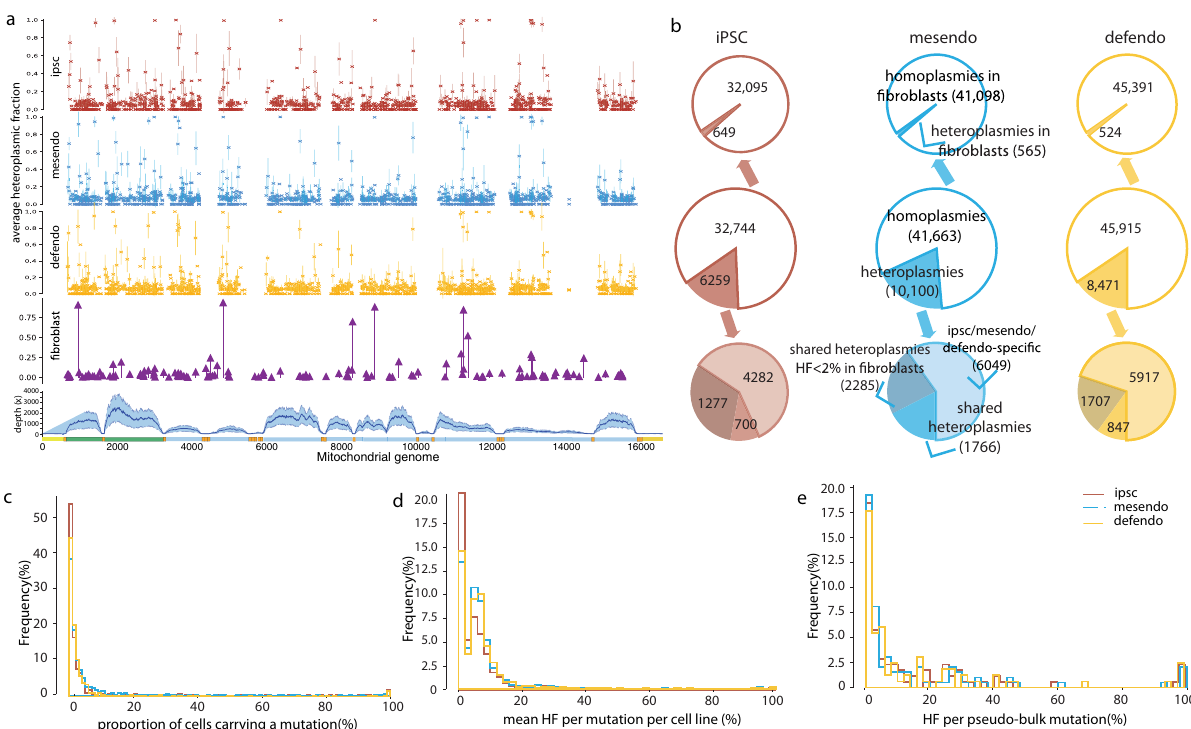
Fig. 4 Overview of mtDNA variants detected by single-cell RNA sequencing. a From top to bottom, mtDNA variants detected from single-cell RNA sequencing, cells de fi ned as iPSC, mesendo and defendo stages are shown separately. Each dot represents the mean HF of each variant per cell line, and the error bar was 95% con fi dence interval; mtDNA variants observed in their fi broblast cells from bulk whole-genome sequencing (purple plot); mtDNA sequencing depth from single-cell RNA sequencing. Mean depth ± standard deviation (s.d.) is shown in the shaded area. Source data are provided as a Source Data fi le . b Overview of the variants detected in the single cells de fi ned at iPSC, mesendo and defendo stages. The text labelled on mesendo stage also applies to the iPSC and defendo cell stages. c Distribution of the proportion of cells carrying the same variant from each cell line. The y axis shows the percentage of mtDNA variants. The majority of the variants were shared by a small proportion of cells from the same cell line. Cells de fi ned as iPSCs, mesendo and defendo cells are shown in different colours. d Distribution of mean heteroplasmy fraction of each variant from each cell line. The y axis shows the percentage of mtDNA variants. The majority of the variants were low-level heteroplasmic variants (mean HF = sum HF/the number of cells carrying the same mutation). Cells de fi ned as iPSCs, mesendo and defendo cells are shown in different colours. e Distribution of heteroplasmy fractions of pseudo-bulk variants from each cell line. The y axis shows the percentage of mtDNA variants. The majority of the variants were low-level heteroplasmic variants in pseudo-bulk heteroplasmy level (HF = sum HF / the total number of cells within each cell line). Cells de fi ned as iPSCs, mesendo and defendo cells are shown in different